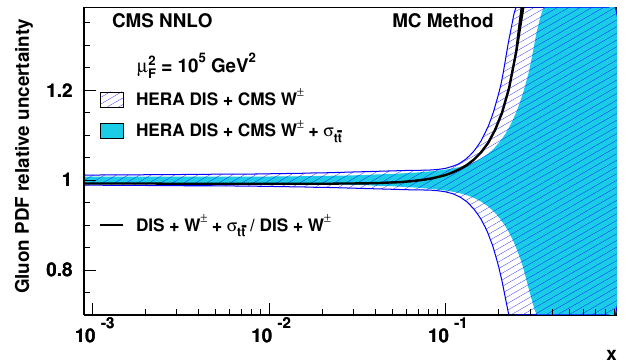
Figure 6 . The relative uncertainties in the gluon distribution function of the proton as a function of x at (cid:22) 2 = 10 5 GeV 2 from a QCD analysis using the HERA DIS and CMS muon charge asymmetry F measurements (hatched area), and also including the CMS (cid:27) The relative uncertainties are found after the two gluon distributions have been normalized to unity. The solid line shows the ratio of the gluon distribution function found from the (cid:12)t with the CMS (cid:27) measurements included to that found tt